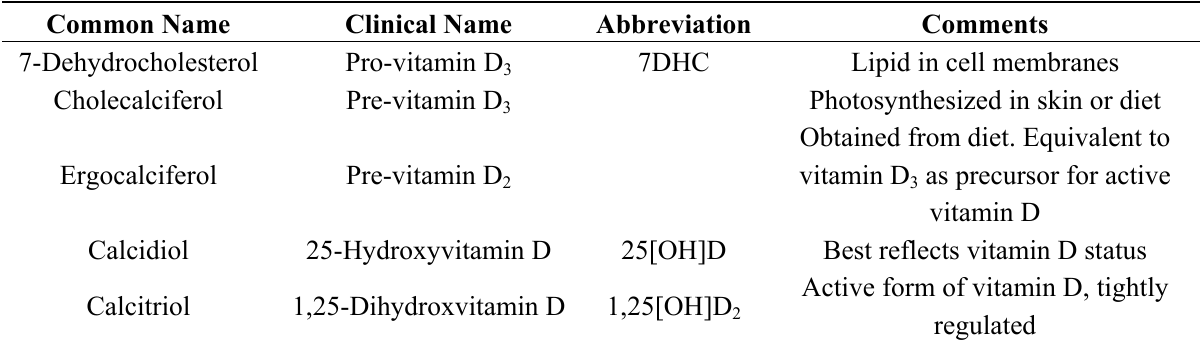
Table 1. Nomenclature of vitamin D precursors and